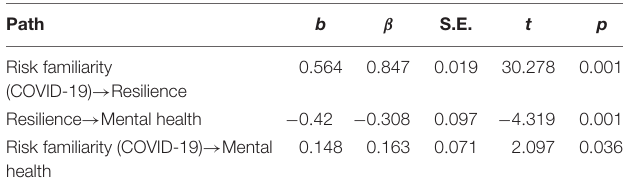
TABLE 2 | Regression analysis of risk familiarity (COVID-19), resilience, and mental